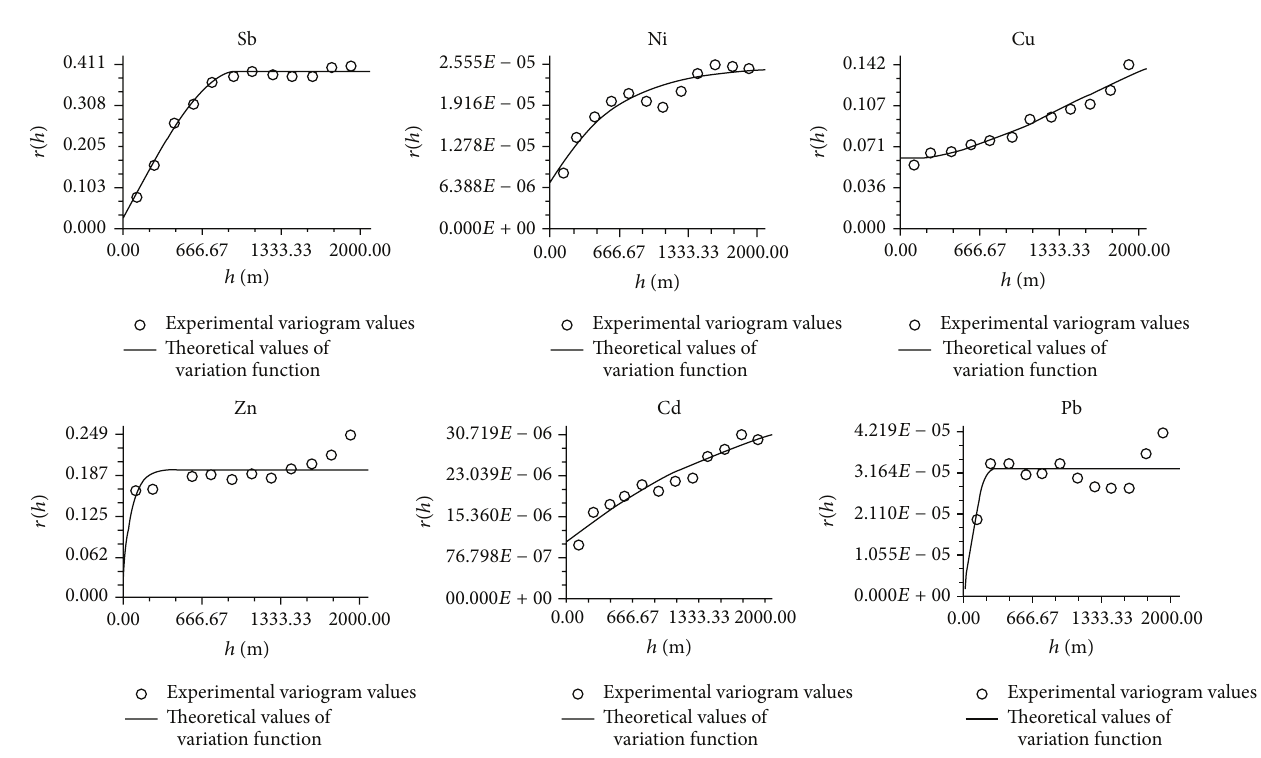
Figure 3: Theoretical semivariation function of Sb, Ni, Cu, Zn, Cd, and Pb in surface runoff in the antimony